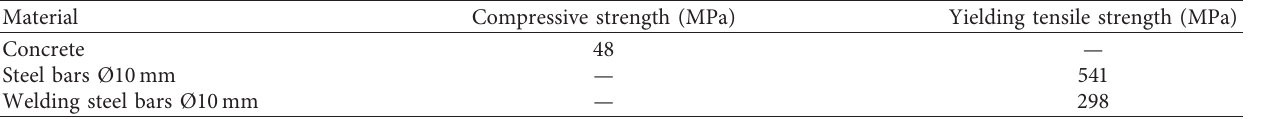
Table 1: Mechanical properties of the concrete and NSM steel